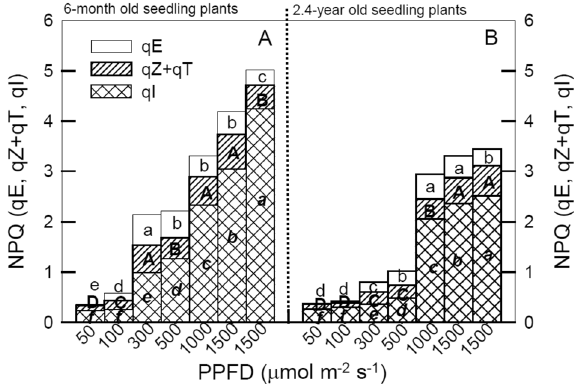
Fig. 3 Composition of non‑photochemical quenching (NPQ) in qE, qZ qT, and qI fractions obtained at illumination for 60 min and + after 30 min of dark period for 6‑month (panel A ) and 2.4‑year (panel B ) Mahonia oiwakensis under 50, 100, 300, 500, 1,000, 1,500, and 2,000 μmol m − 2 s − 1 PPFD at 25 °C. Different letters indicate significant differences in the Tukey’s HSD analyses at seven LI treatments ( p < 0.05). Each point represents the mean of 5